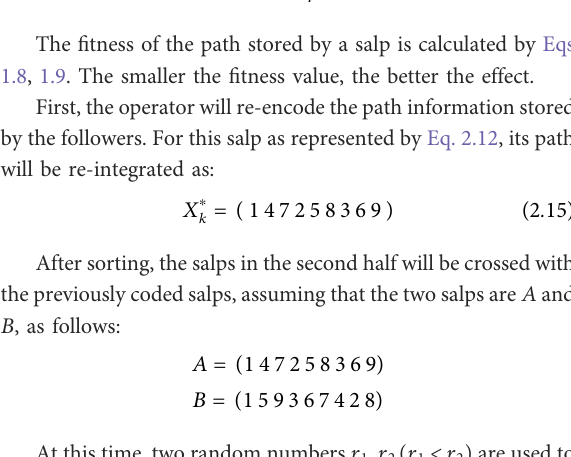
Algorithm 2. initialize population and de fi ne ubj and